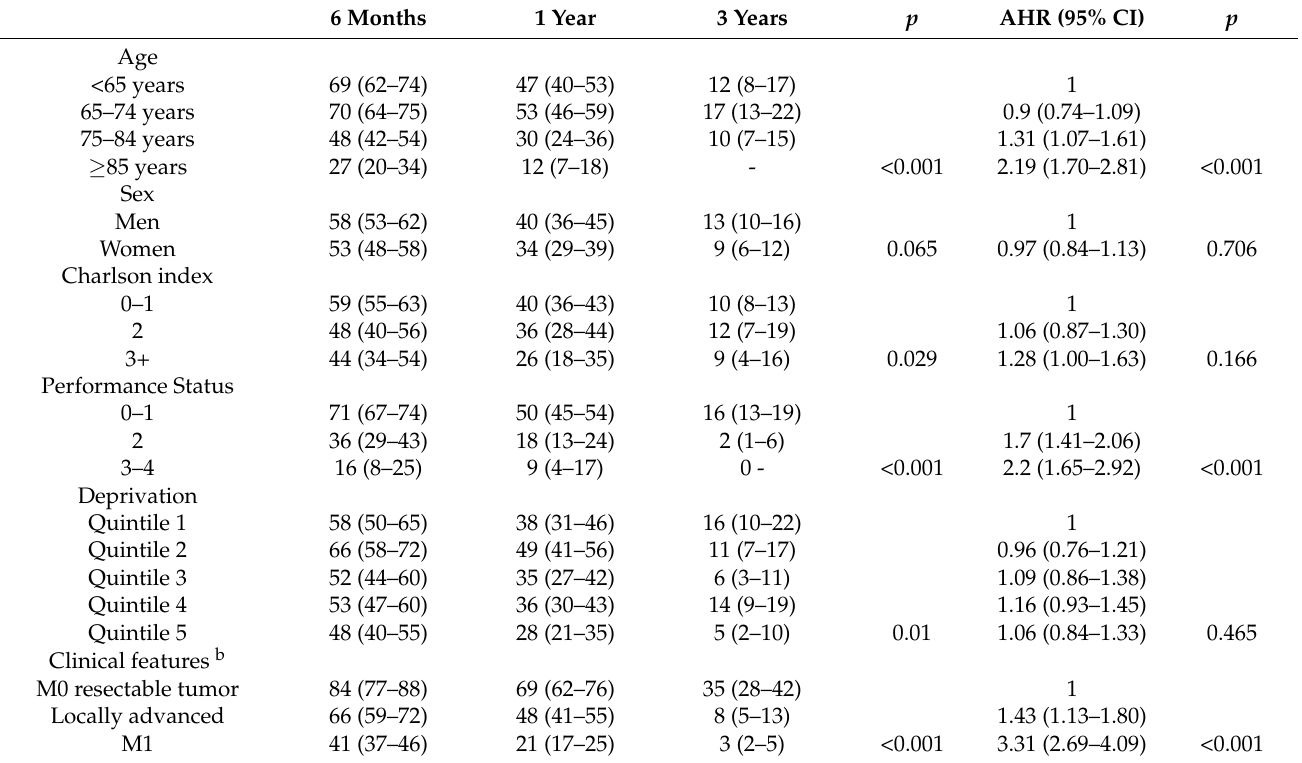
Figure 1. Three-year cumulative probability of progression or death according to treatment modalities (surgical resection and first-line chemotherapy regimen). Table 5. Net survival (% and 95% Confidence Intervals) at 6 months, 1 year, and 3 years in patients with pancreatic cancer ( n = 912). Uni and multivariate analysis a